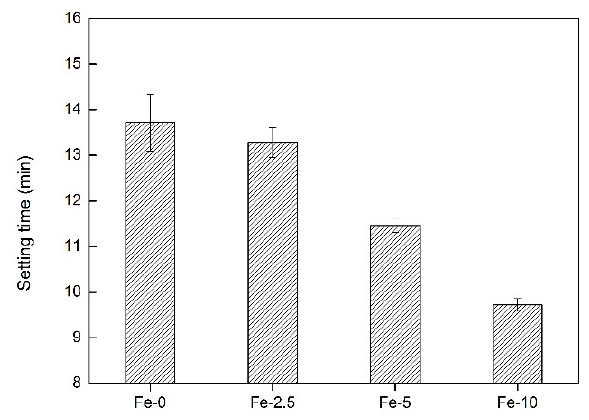
Figure 1. The setting time of Fe-0, Fe-2.5, Fe-5 and Fe-10 bone cement samples.